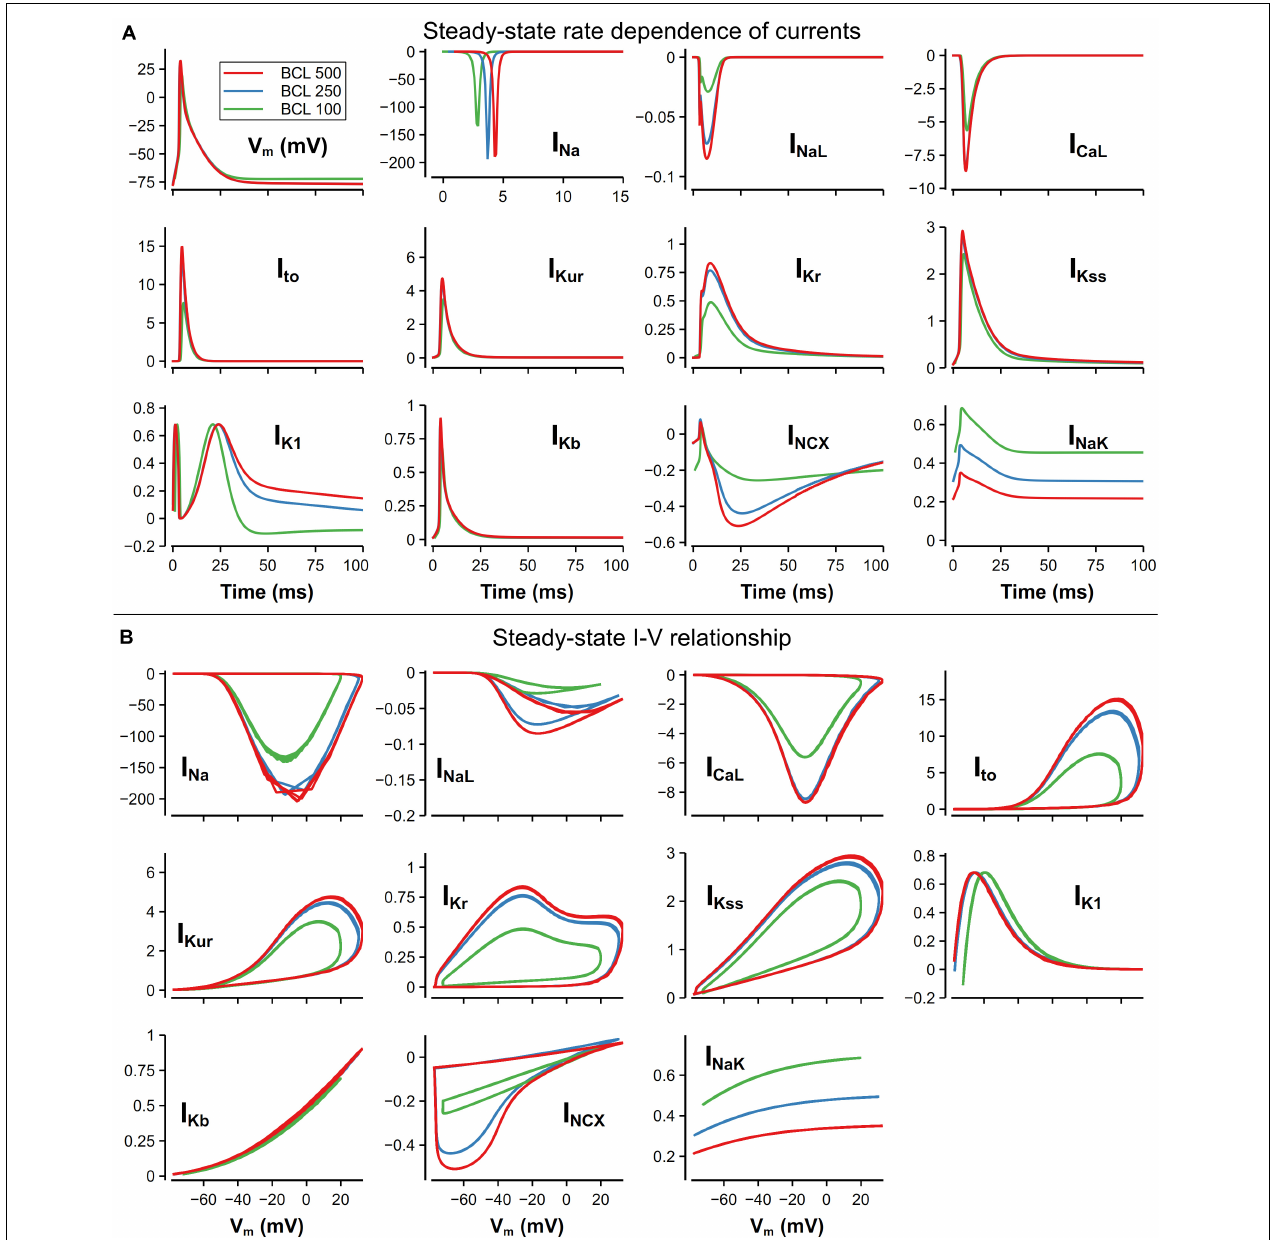
FIGURE 12 | Steady-state rate dependence of currents and corresponding I–V relationship. The unit of all currents is pA/pF. (A) Currents against time at various CLs. The traces of I Na were slightly moved along time to avoid overlapping. (B) I–V relationship of currents at various CLs.